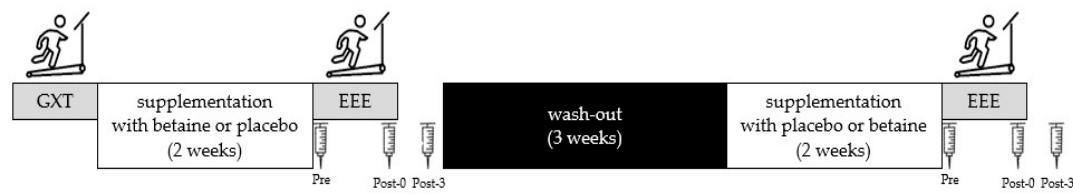
Figure 1. Experimental scheme. GXT, graded exercise test; EEE, exhaustive endurance exercise; Pre, before exercise; Post-0, immediately after exercise; Post-3, 3 h after exercise.